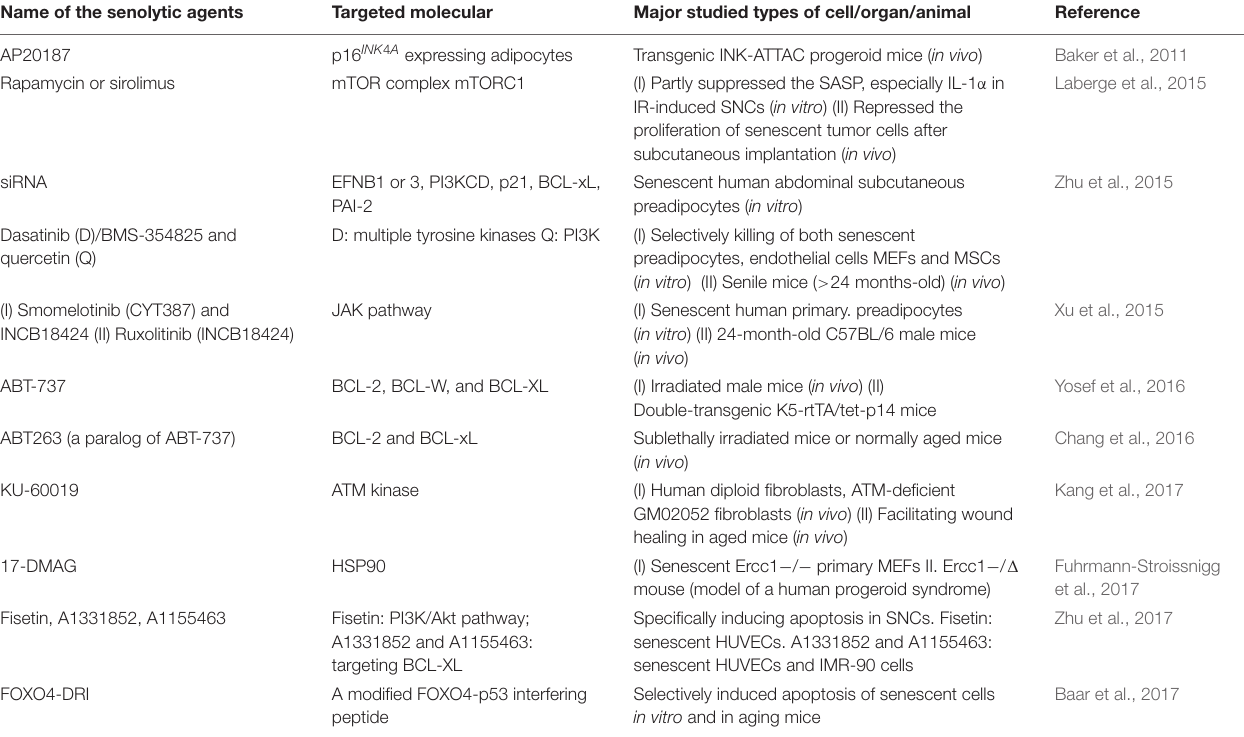
TABLE 1 | A summary of the first publication of important small molecule senolytic agents (small molecules that can selectively kill senescent